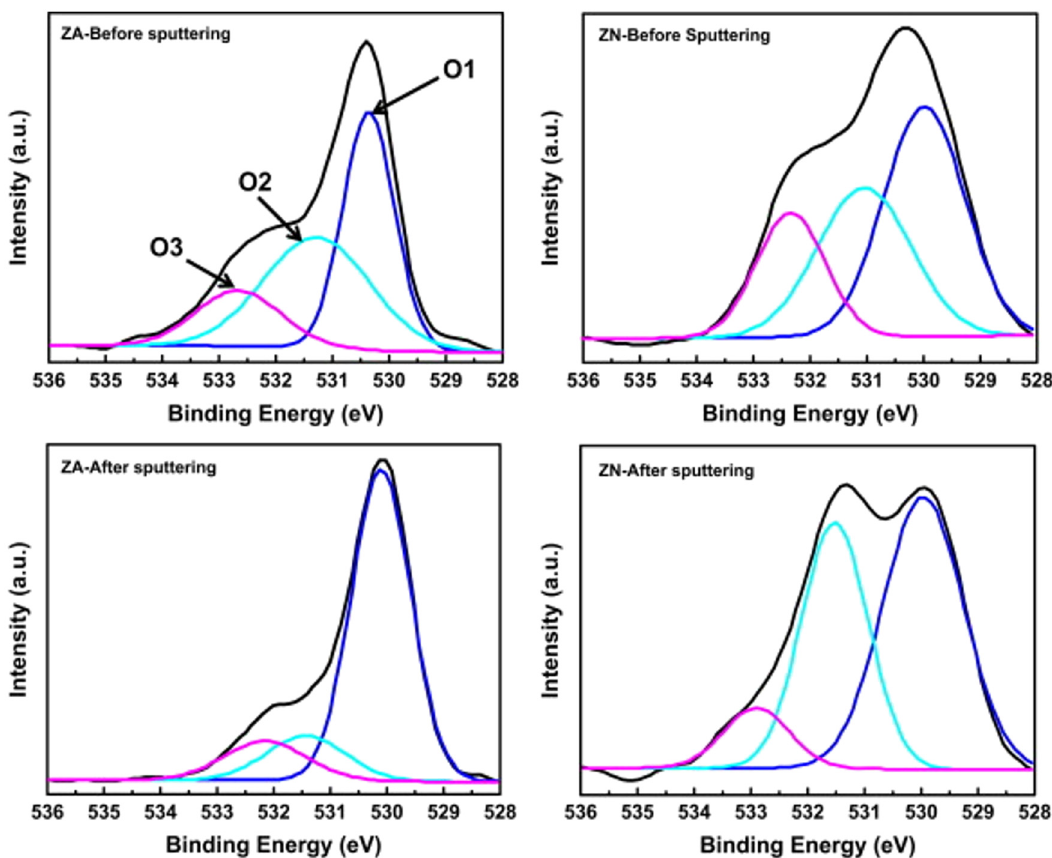
Figure 7: O 1s XPS peak of ZnO NPs before and after Ar + sputtering. Reproduced with permission from Elsevier [ 166 ]